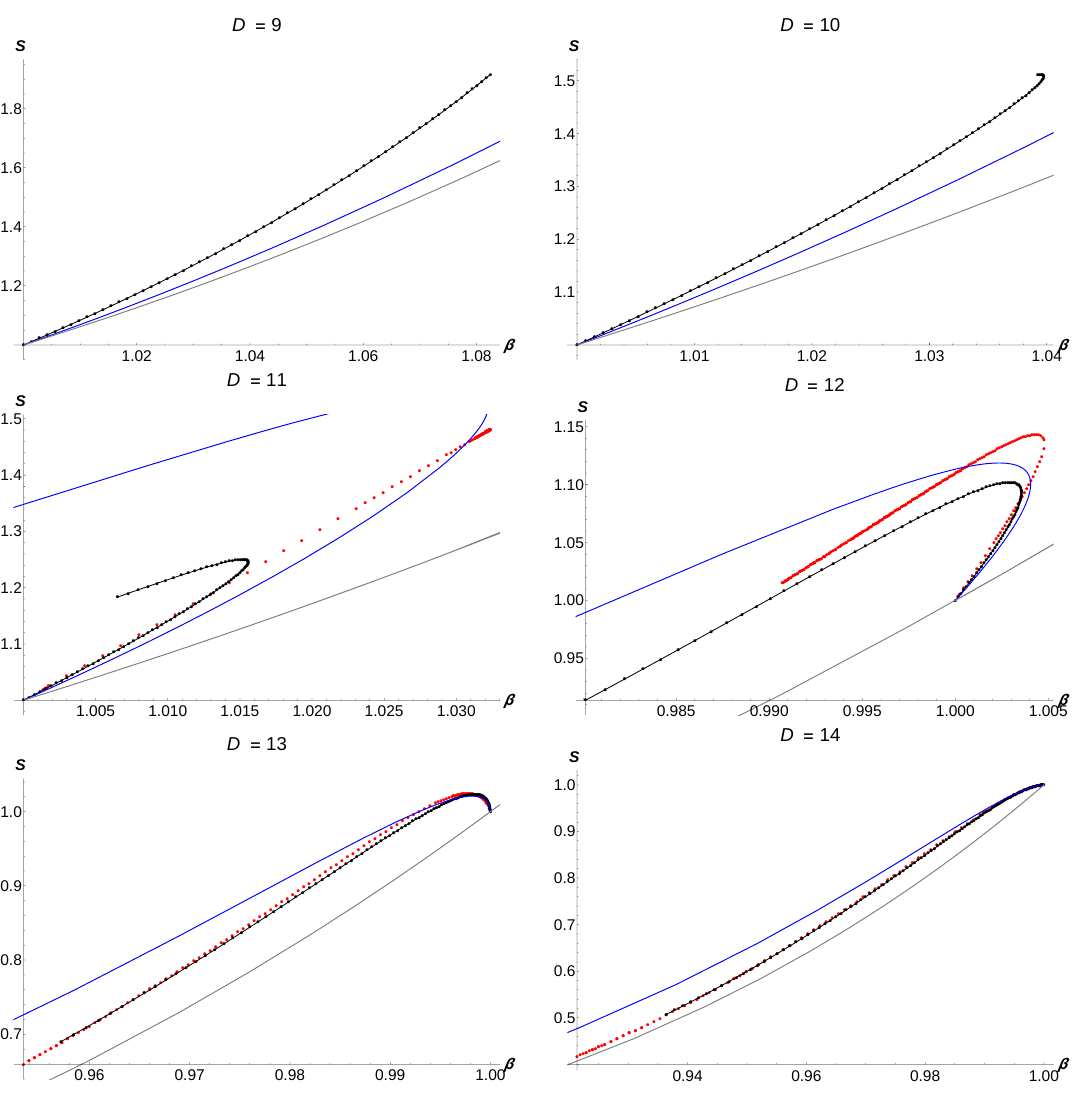
Figure 6 . Entropy S vs. inverse temperature (cid:12) . Black dots: large- D numerical results for NUBS. Blue solid: large- D perturbative solution for NUBS. Red dots: (cid:12)nite- D full-numerical NUBS in [15]. Gray solid: uniform black string ( S UBS = (cid:12) n +1 ). From the branching point at S = (cid:12) = 1, we see that S increases when D < 13 : 6 and decreases when D > 13 :